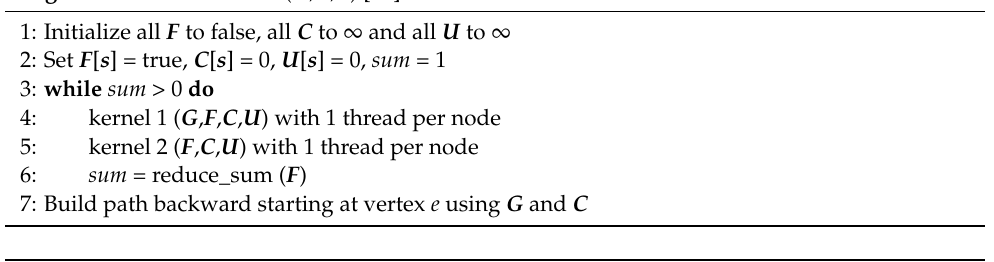
Algorithm 4. kernel 1 ( G , F , C , U ) [proposed implementation]